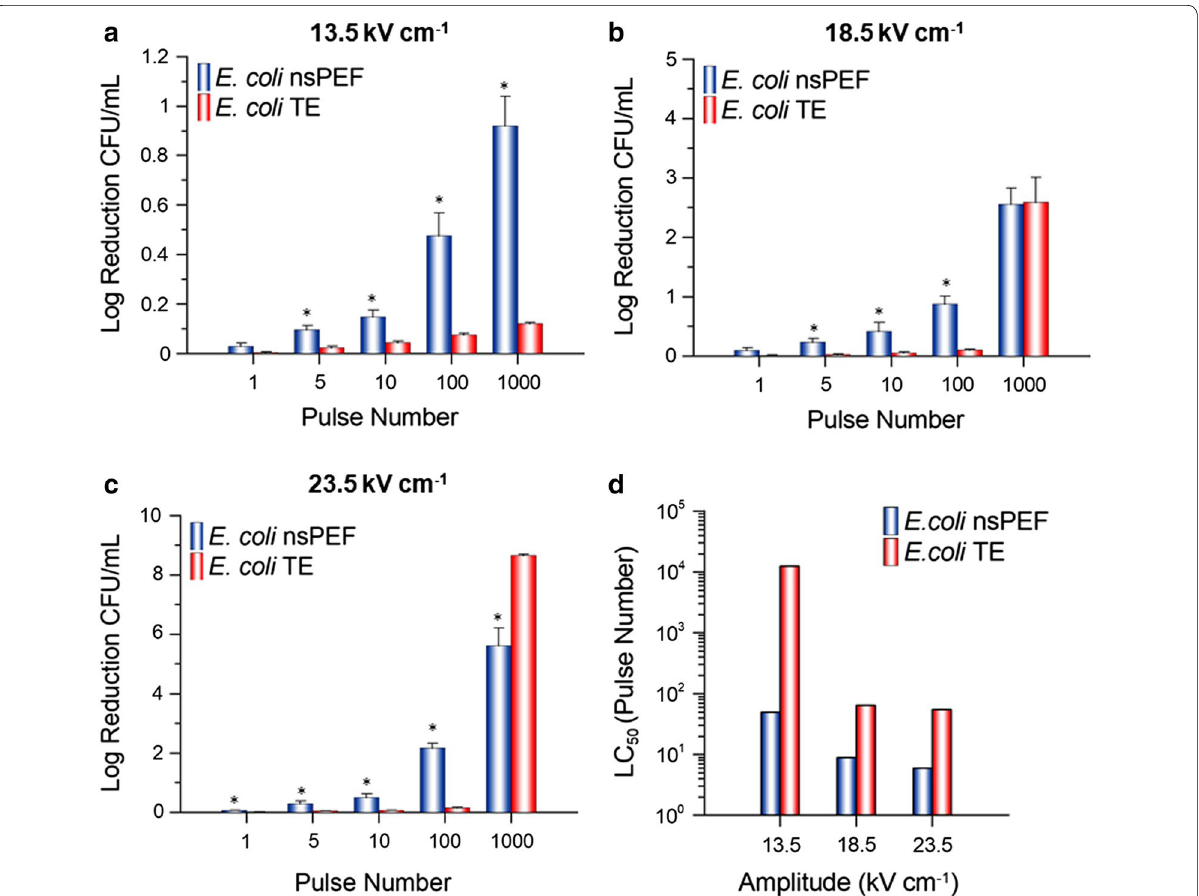
Fig. 3 E. coli cell inactivation. Cell inactivation (log reduction CFU mL − 1 ) ( a – c ) and LC 50 values ( d ) for E. coli exposed to a 600-ns PEF (blue) or its respective TE (red) at an amplitude of 13.5, 18.5 or 23.5 kV cm − 1 and 1, 5, 10, 100 or 1000 pulses. nsPEF results are normalized to the sham and are the mean plus SE of six independent experiments (n 6). TE results are normalized to the sham and are the mean plus SE of three independent = experiments (n 3). LC 50 values were calculated by utilizing the mean log reduction CFU mL − 1 at each amplitude. An asterisk represents a = statistically significant difference (p 0.05) between the nsPEF and TE exposure for that pulse ≤